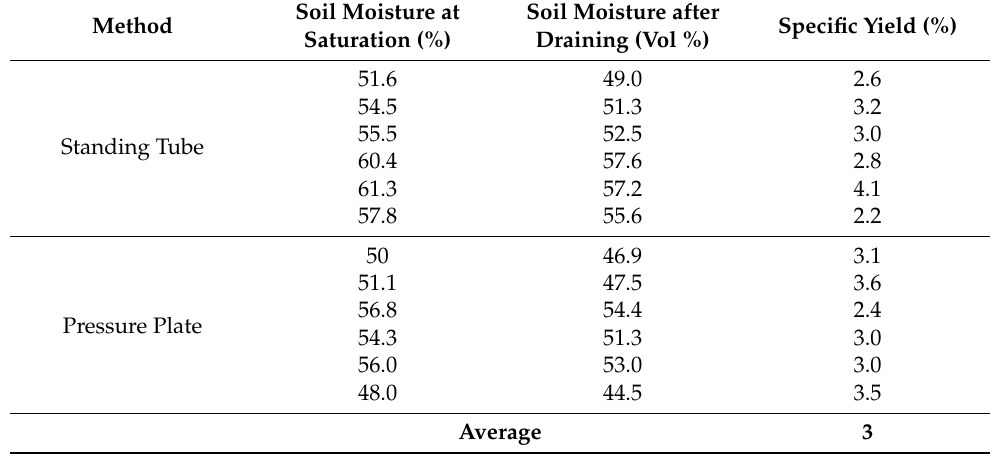
Table 1. Specific yield (%) was obtained from the pressure plate and standing tube methods.